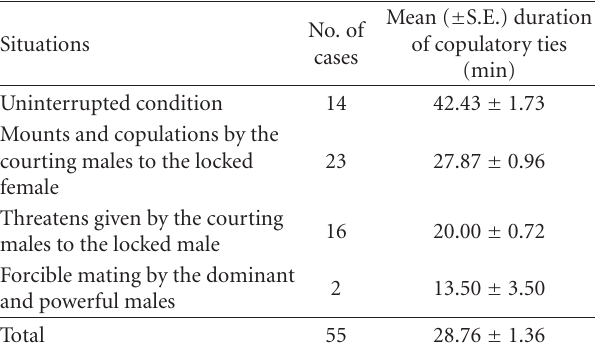
Table 4: Duration of copulatory ties in di ff erent